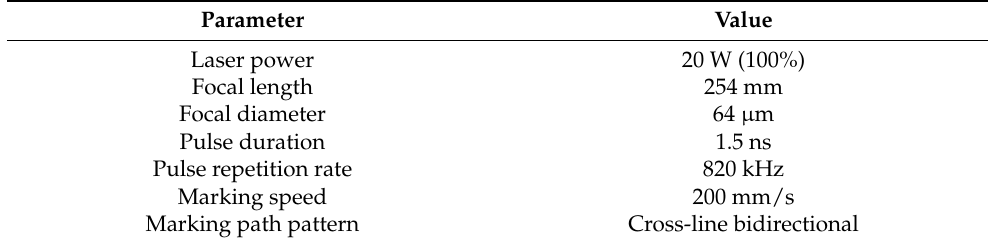
Table 1. Parameters of laser surface texturing.